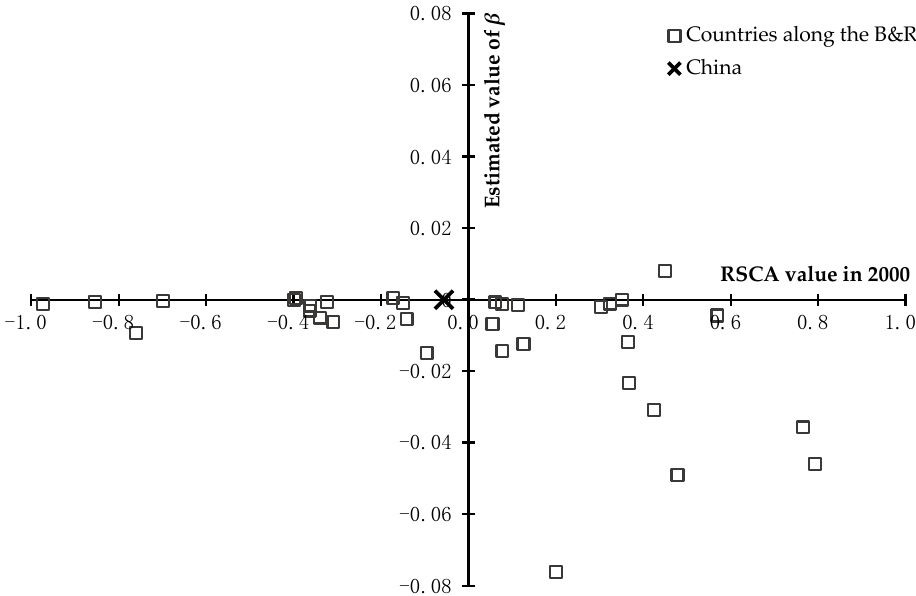
Figure 5. The mean annual change pace of the RSCA values of total agricultural products in countries along the B&R and China from 2000 to 2018. The x -axis represents the RSCA value in 2000; and the y -axis represents the estimated value of β A advantage from 2000 to 2018, and β A from 2000 to